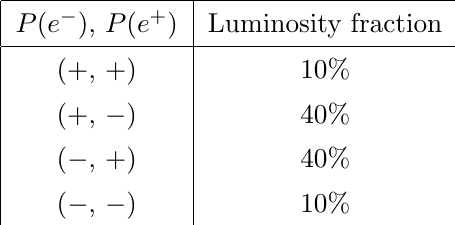
Table 1 . Luminosity fraction for the four beam polarisation con(cid:12)gurations, taken from ref. [37]. could be part of a multi-component DM theory. For all these reasons we will not impose any relic density